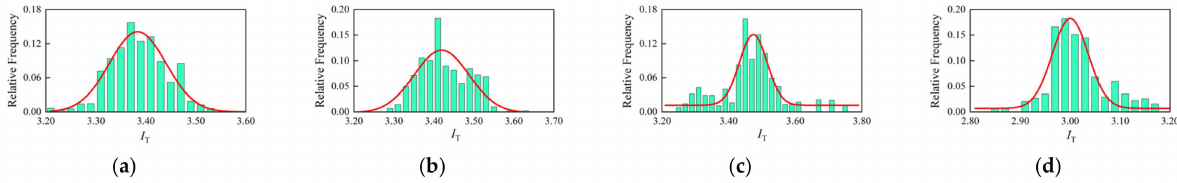
Figure 13. Posteriori relative frequency distribution of member 469. ( a ) Healthy; ( b ) mild injury; ( c ) moderate damage; ( d ) severe injury.